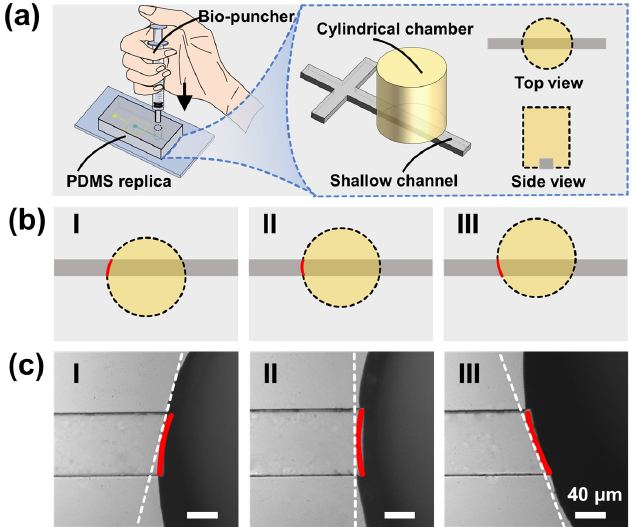
Figure 2. Punching fabrication. ( a ) I: Schematic diagram of the punching operation ( b ) Three typical illustrations of the step microstructures. I: The cylindrical hole is below the central line of the straight microchannel. II: The cylindrical hole is right on the central line of the straight microchannel. III: The cylindrical hole is above the central line of the straight microchannel. ( c ) Microscopic images of the step boundaries, corresponding to the illustrations above. It is worth noting that the bio-puncher can smoothly cut the straight channels without edge-tearing or cracking.